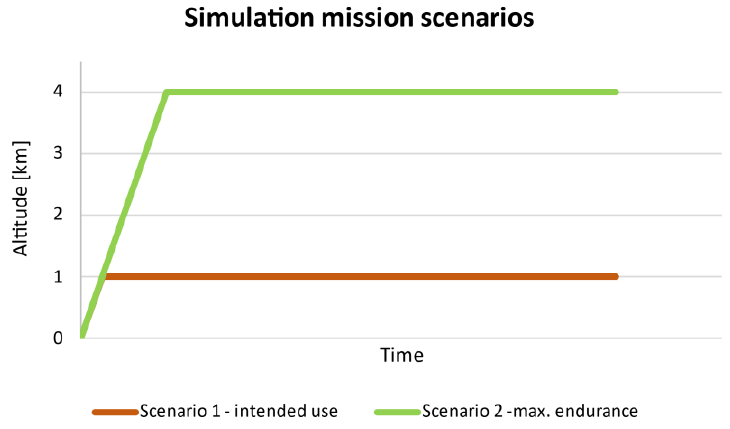
Figure 7. Mission scenarios considered in the simulation model.